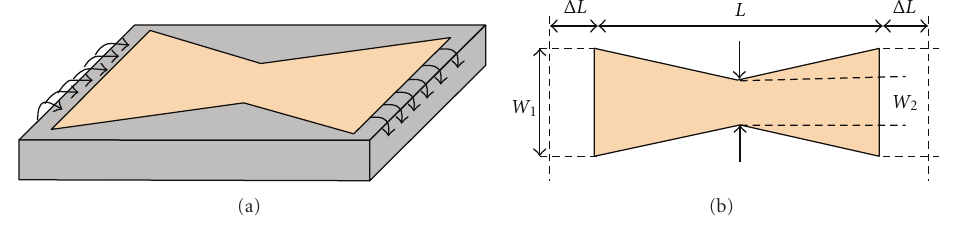
Figure 1: Bow-tie antenna and its e ff ective length.